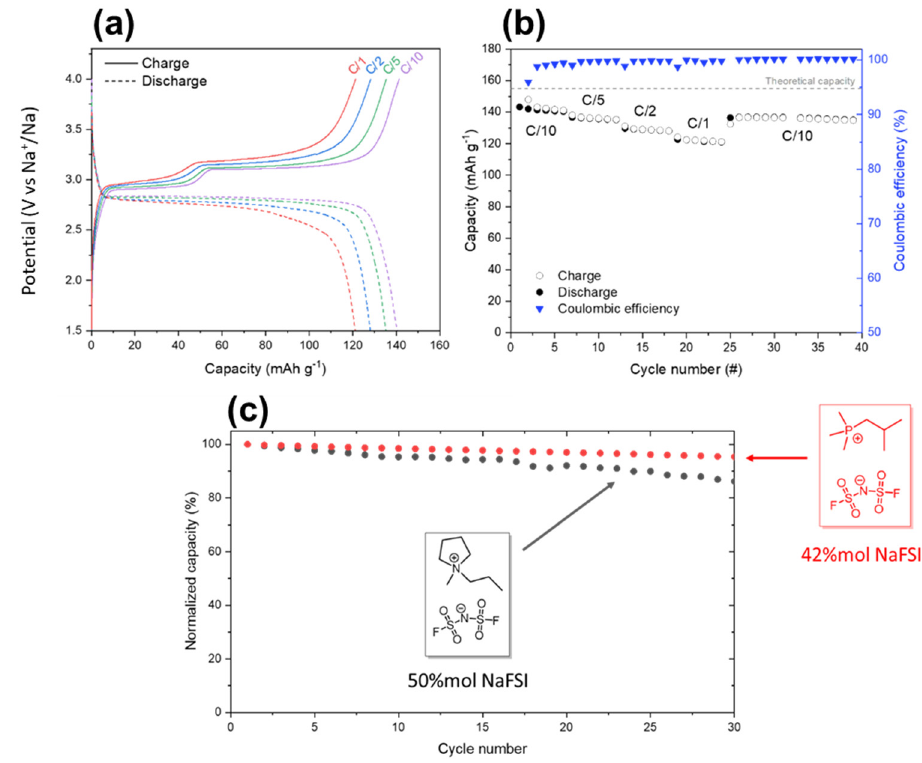
Figure 4. ( a ) Cycling behavior at 50 °C of a Na/iongel membrane/NaFePO 4 cycled in the range of 1.5–4 V vs. Na + /Na at different C-rates; ( b ) specific capacity vs. cycle number plot; ( c ) normalized capacity as a function of cycle number for the electrolyte reported in this work (red points) and